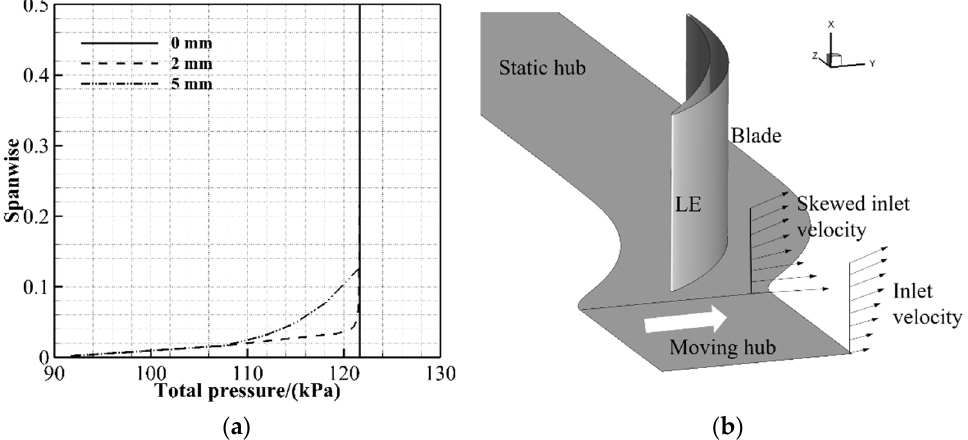
Figure 3. Numerical simulation of IBL thickness and skew: ( a ) Inlet total pressure distributions; ( b ) Generation of boundary layer skew.